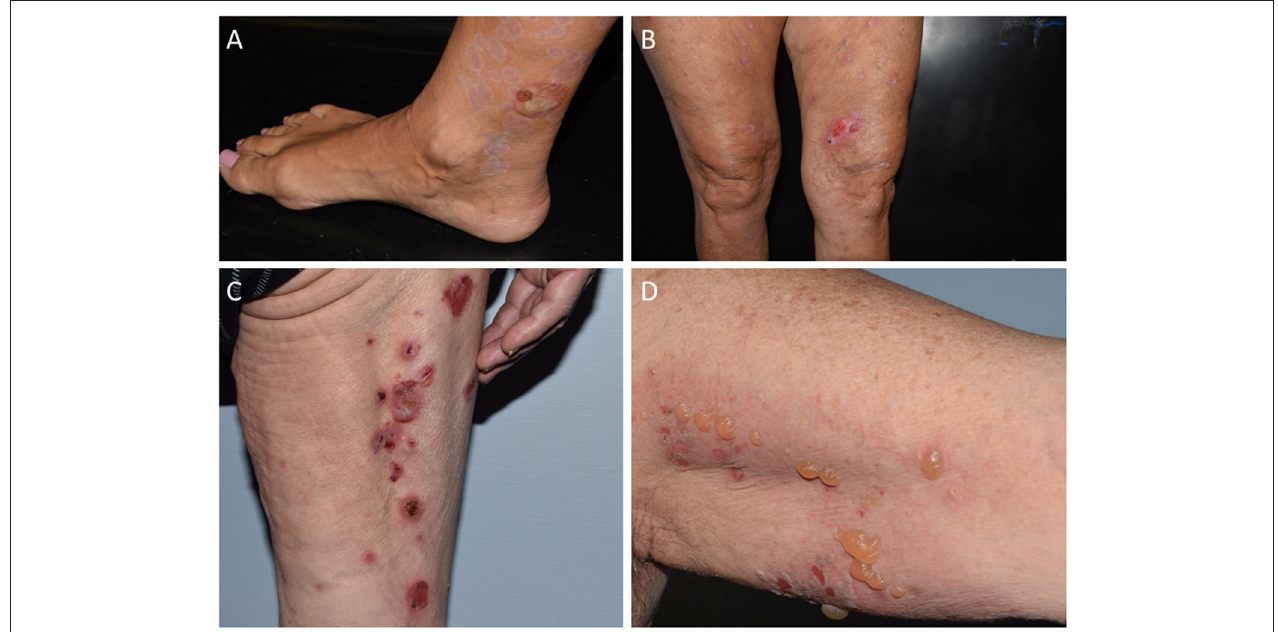
FIGURE 1 | Clinical spectrum of vaccine-associated BP patients. (A) Acral distribution of active blister associated with older lesions in partial resolution, resulting in mild erythema and hypopigmentation. (B) Sero-hemorrhagic bullous, pruritic eruption on medial surface of left thigh, surrounded by multiple prurigo-like specific lesions. (C) Linear distribution of erythematous blisters, resulting in crusts and erosions. (D) Blisters and erosions with mild erythema located on left axilla.